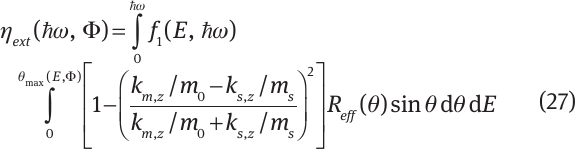
Figure 13: Extraction efficiency of the hot carriers generated on the metal/Si interface by the SPPs excited with λ = 1500 nm photons. (A) Smooth interface; reflection is not taken into account [Eq. (27)]. (B) Smooth interface; reflection is taken into account [Eq. (27)]. (C) Rough interface; complete extraction of all above-the-barrier carriers [Eq. (28)]. (D) Rough interface; momentum conservation rules are relaxed, but transitions into transverse valleys of Si are not allowed [Eq. (29)]. (E) Rough interface; momentum conservation rules are relaxed and the transitions into transverse valleys of Si are allowed [Eq.